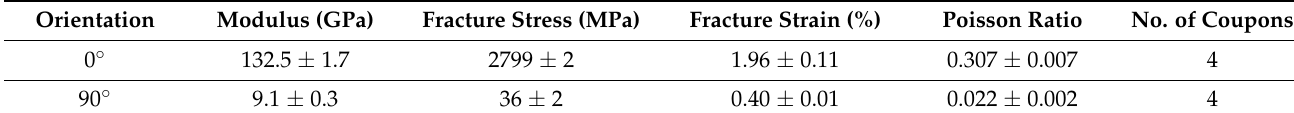
Figure 3. Stress–strain curves in tensile mode for different fibers orientations; ( a ) 0°; ( b ) 90°. Table 1. Tensile properties in both orientations for four coupons.